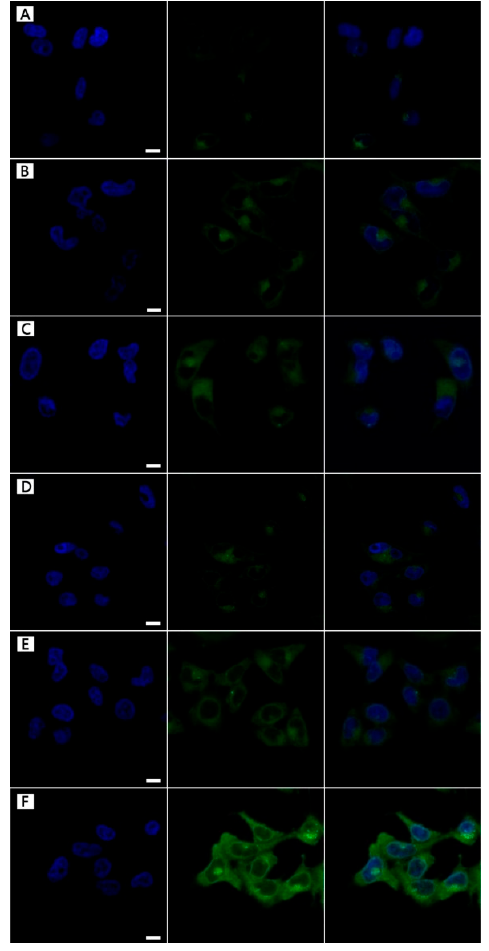
Figure 5. The localization of FITC-modified LHNPs from CLSM: FITC–LHNPs ( A – D ), FITC–MLHNPs ( B E ), FITC–FA–MLHNPs ( C – F ) in HeLa cells for 4 h ( A – C ) and 12 h ( D – F ). Bar: 1 μ m.